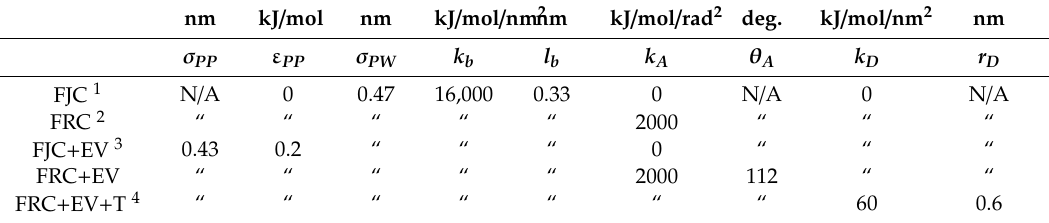
Table 1. Parameter values for the chain models considered. N / A means not applicable—that the value was irrelevant because its potential was set to zero. A blank space means the value was varied. The double quote means the value is repeated from the cell above. N , and (cid:15) PW are not listed in the table because they were allowed to vary for each chain model. Simulation temperature was 300